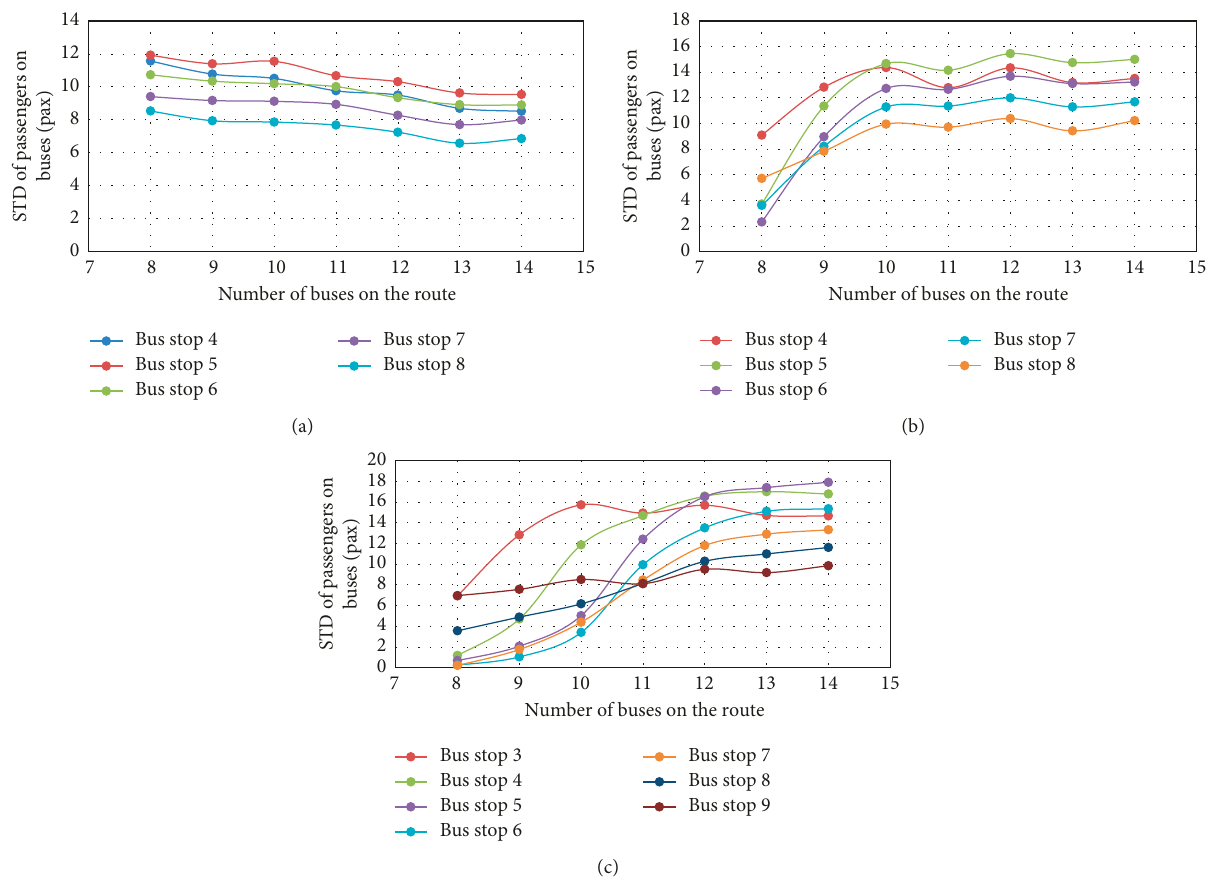
Figure 10: STD of passengers on buses at bus stops located at the busy section of the bus route. (a) Group r1. (b) Group r2. (c) Group